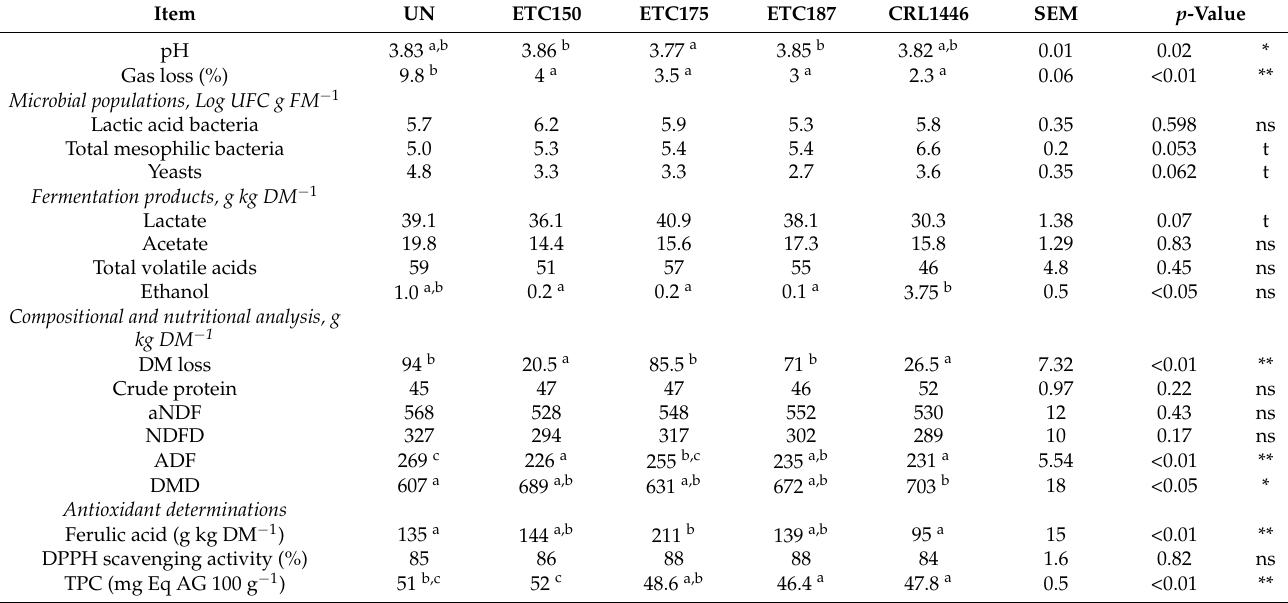
Table 4. pH, microbial, chemical, and nutritional measures of corn silages uninoculated (UN) or inoculated with FAE+ strains, after 100 days of